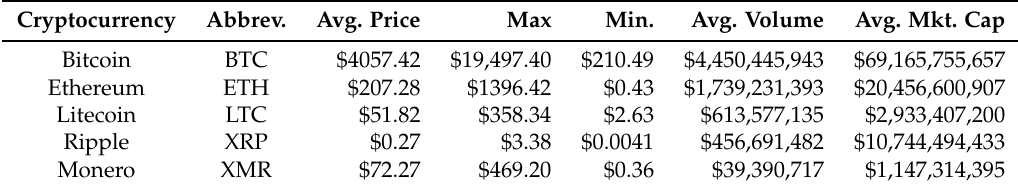
Table 1. Sampled Cryptocurrencies